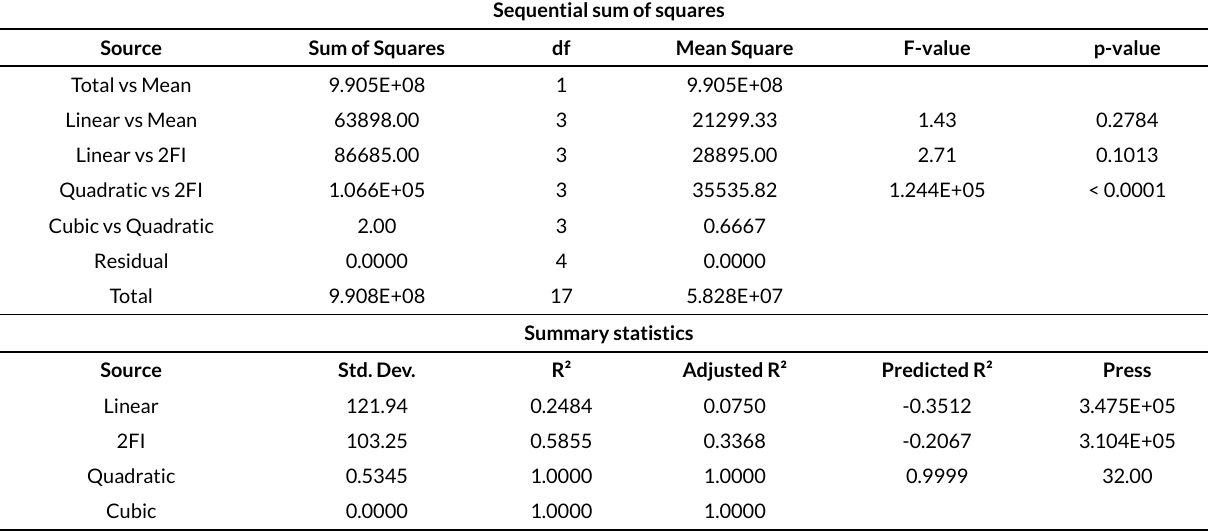
Table 4. The sequential fitting model with theoretical plate number as a response to quantify acetic acid content.